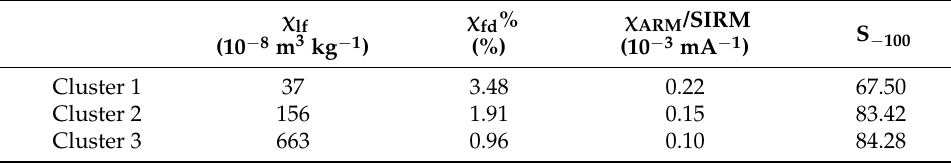
Table 3. Parameter means for the four-cluster